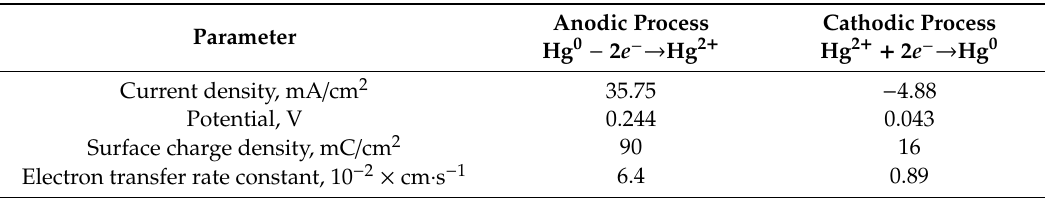
Figure 3. ( a ) Voltammograms related to the electrodeposition and anodic stripping of Hg on the epitaxial graphene electrode in 0.1 M HClO 4 + 0.1 mM Hg 2 + at v = 20 mV · s − 1 scan rate. ( b ) Schematic representation of the one-step and two-step Hg-involved redox reactions at the epitaxial graphene surface. Table 1. Parameters describing the electrochemical behavior of the Hg 2 + / Hg 0 redox couple at room temperature at the epitaxial graphene